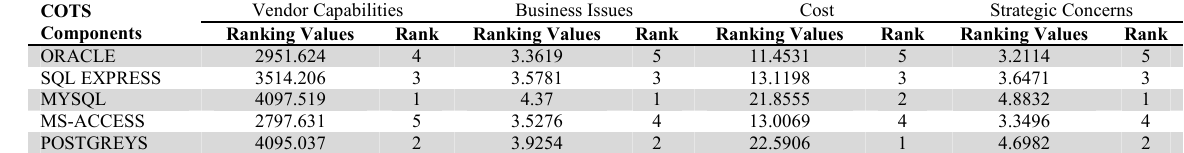
Ranking values and ranks of COTS components using the Fuzzy Matrix method Vendor Capabilities COTS Components